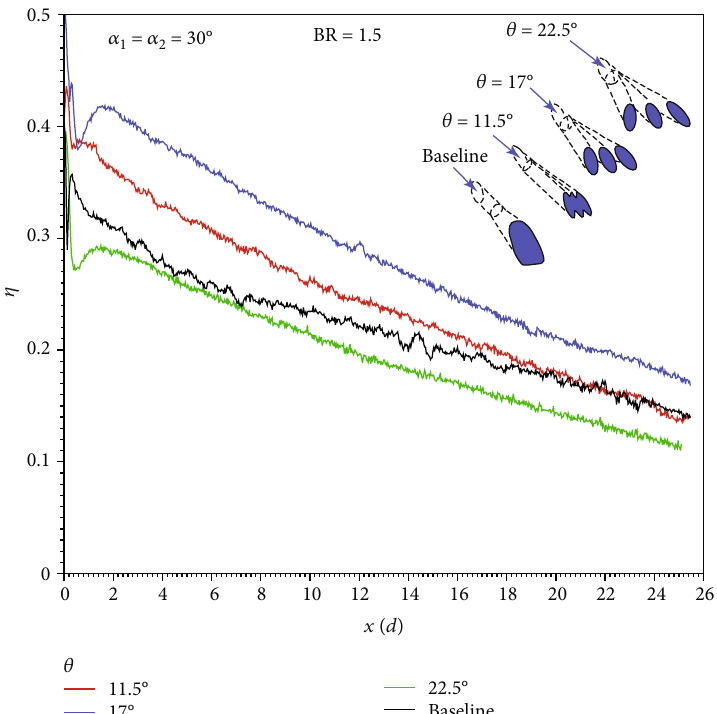
Figure 19: Streamwise (laterally averaged) fi lm e ff ectiveness variations for α BR = 1 : 5 .